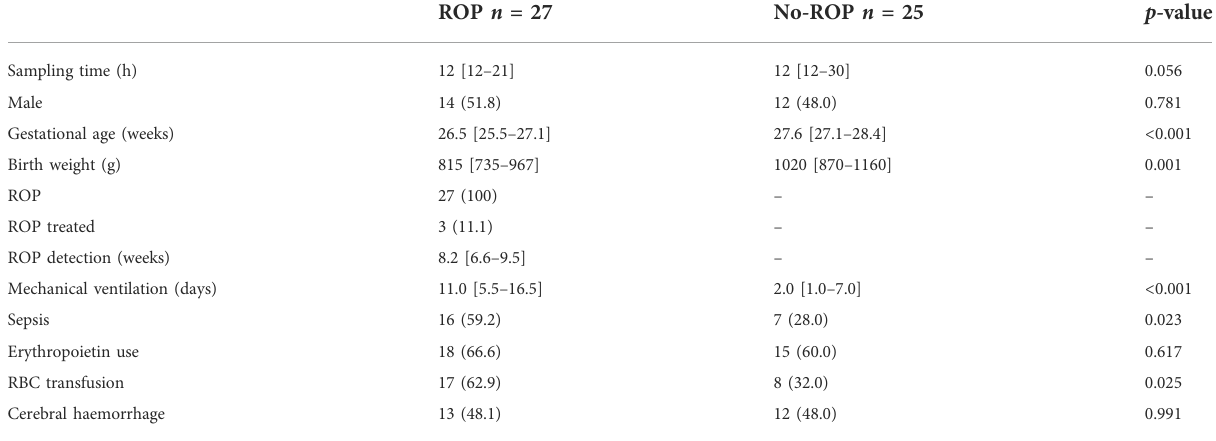
TABLE 1 Main characteristics of the OmegaROP